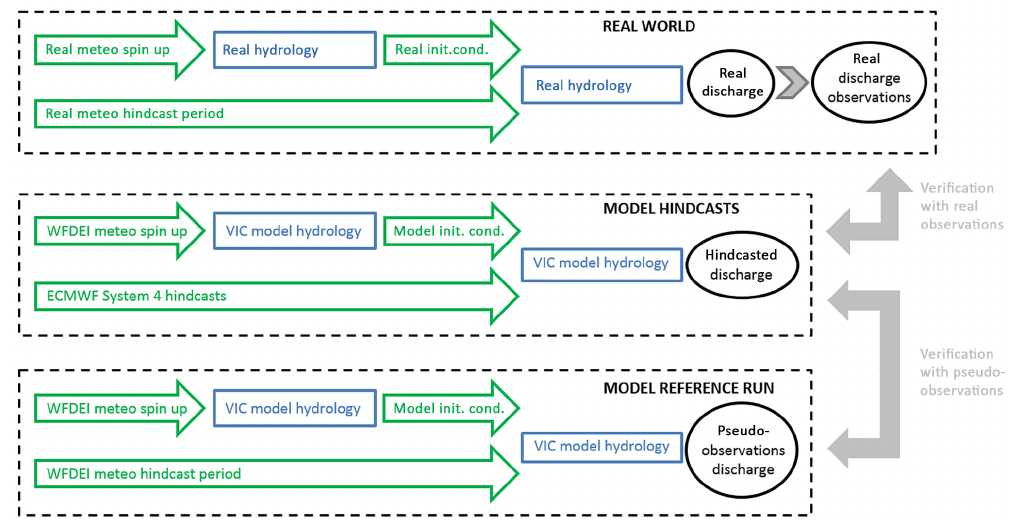
Figure 1. Set-up of the present study. The lower two dashed boxes summarise the set-up of the forecast system itself. The upper dashed box represents the real world. The filled arrows on the right-hand side represent verification of hindcasts (in the middle) with pseudo-observations (bottom) and with observations of real discharge (top). In each box the flow at the upper left represents the creation of initial conditions while the flow below that (a single arrow) represents the meteorological